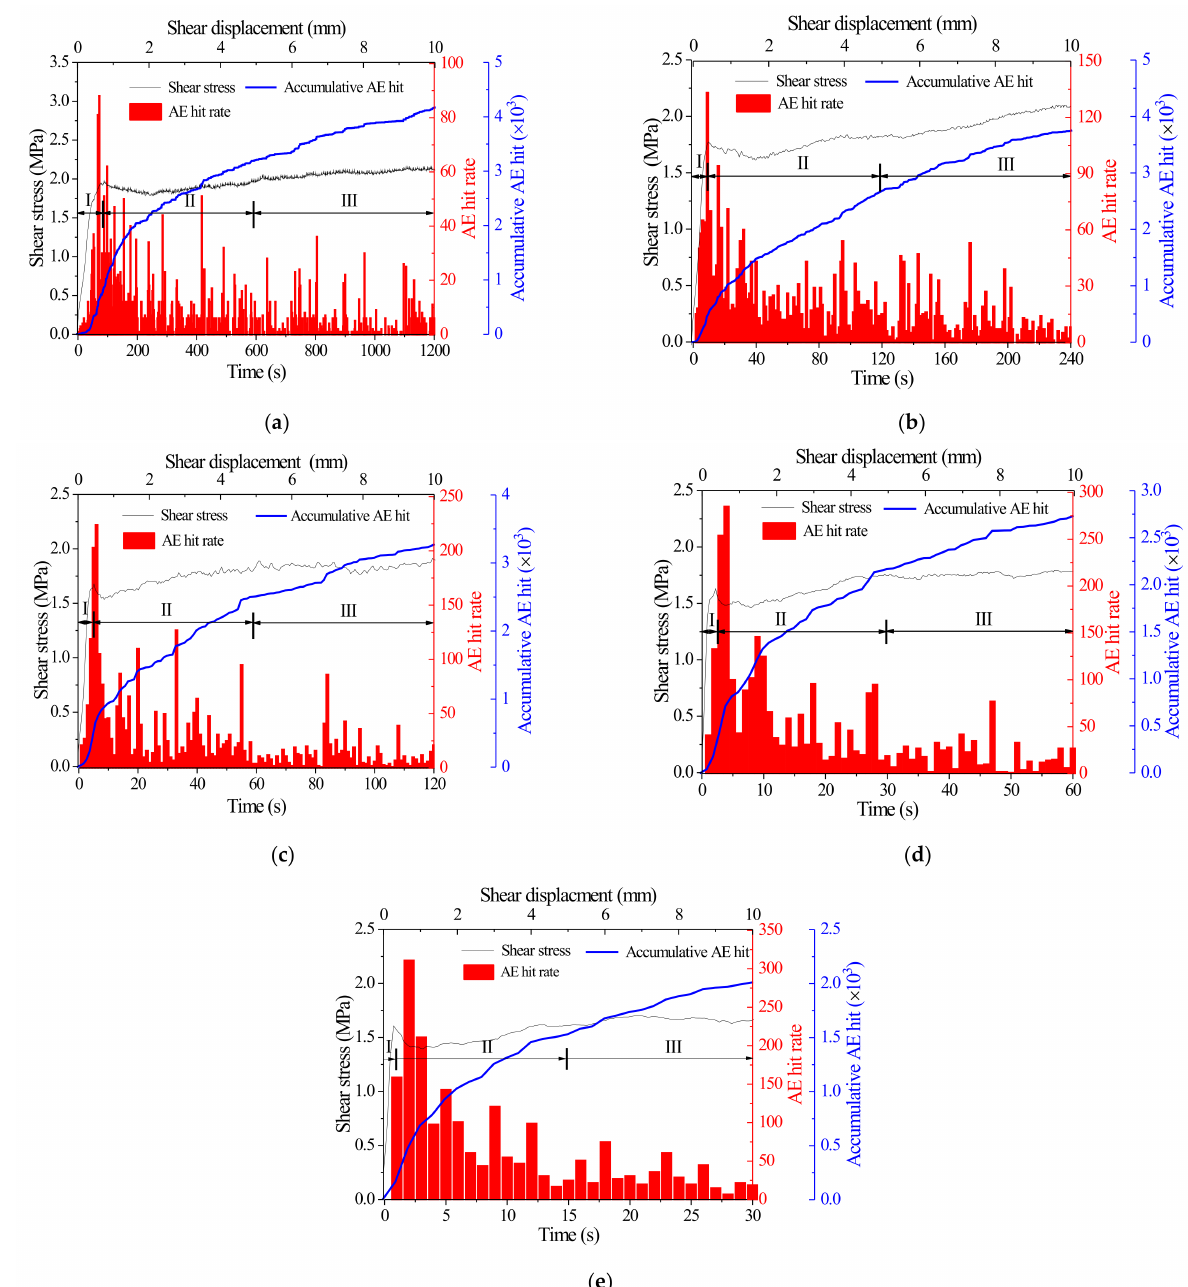
Figure 14. Difference between AE hit rate and cumulative AE hit of joints with diverse shear rates under different CNS conditions. ( a ) Shear rate = 0.5 mm/min; ( b ) Shear rate = 2.5 mm/min; ( c ) Shear rate = 5 mm/min; ( d ) Shear rate = 10 mm/min; ( e ) Shear rate = 20